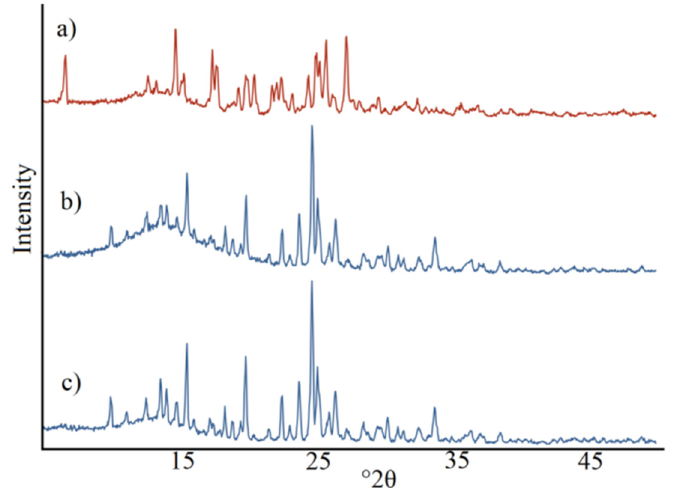
Figure 4. Di ff raction patterns of: ( a ) lorazepam mixture with nicotinamide prepared at a 1:1 molar ratio by a laboratory stirrer, ( b ) lorazepam co-crystals with nicotinamide prepared by liquid-assisted grinding method, and ( c ) lorazepam co-crystals with nicotinamide prepared by slurry evaporation method.